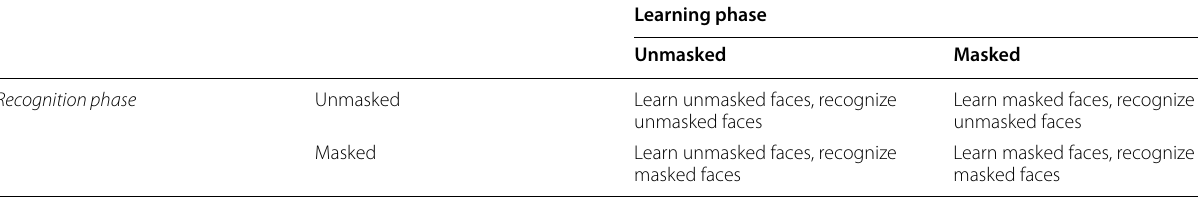
Table 1 Four mask conditions used in the design